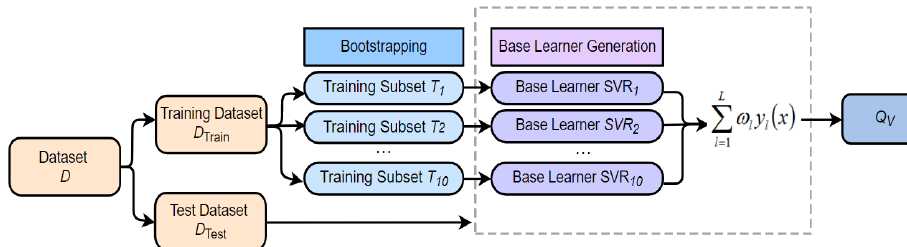
Figure 9. SVR model based on